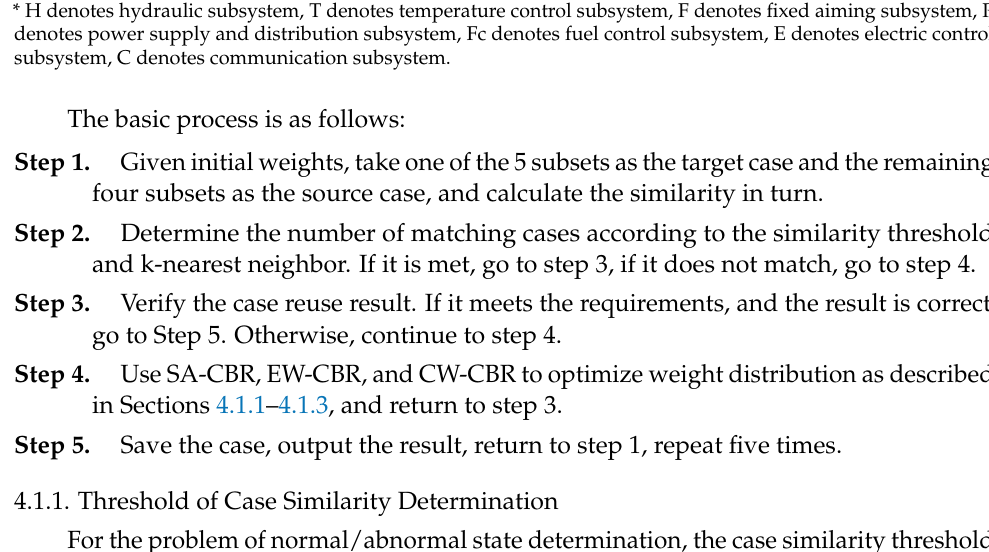
Table 4. Data set for the degree of health performance. Subset Case Produced * Number of Sample Number of Attribute B1 H 1030 8 B2